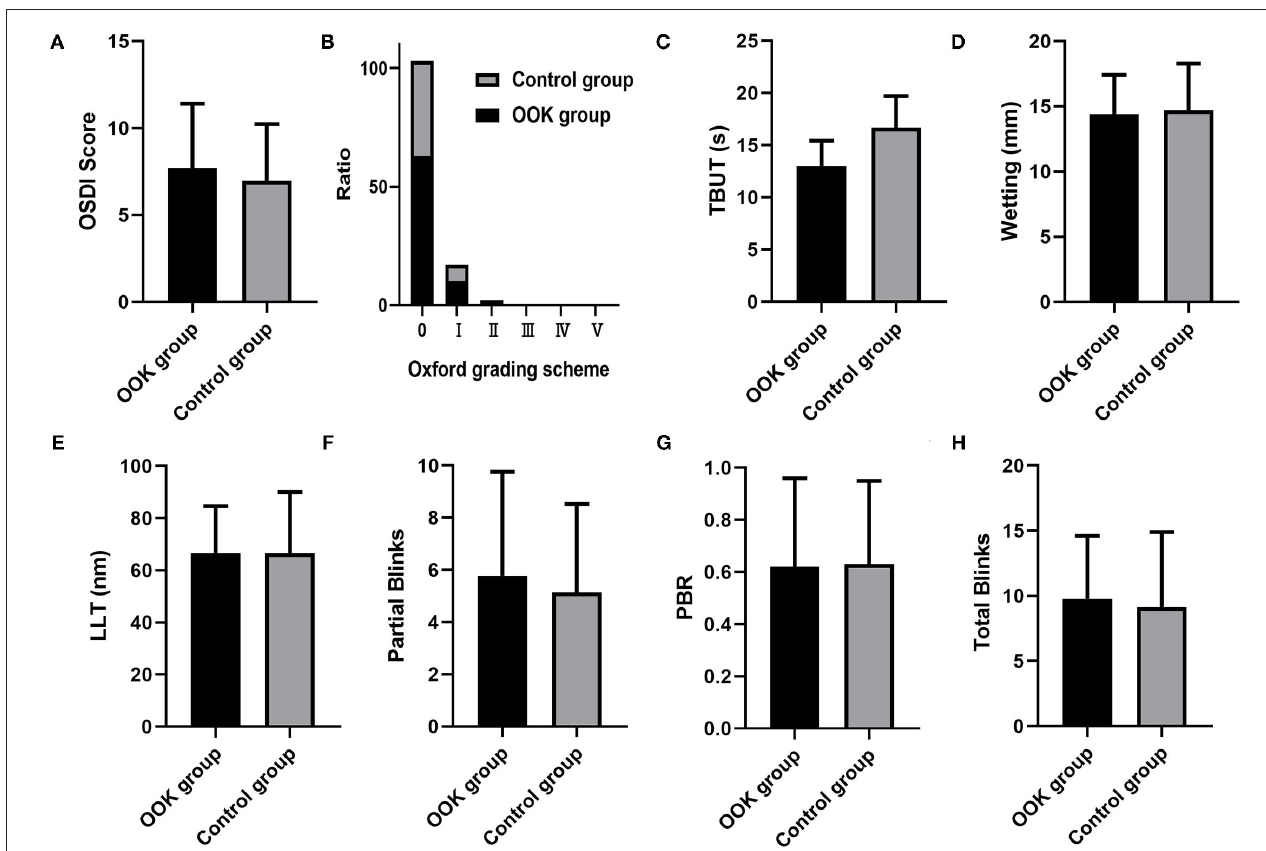
Figure 2 demonstrated the distribution of meibomian gland dropout in the OOK group and control group, and the meiboscore of each group was lower than 3. In the lower eyelids, the OOK group showed a higher proportion of light (51.35%) and medium (5.40%) loss of meibomain glands, while the meiboscore was limited to mild loss (1) without any case of moderate or severe loss in the control group (33.3%) ( p < 0.01). There was no statistically significant difference in the upper meibomian gland dropout ( p = 0.25), upper and lower score of meibum properties ( p = 0.71, 0.83), and meibomian gland expressibility ( p = 0.79, 0.13) in each